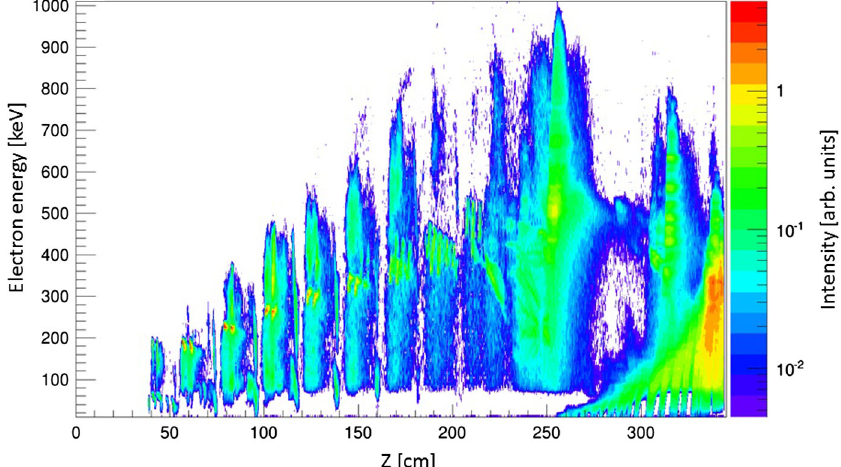
FIG. 14. Time-integrated correlation map between the electron energy and their position along Z after the electrons reached the outer conductor.